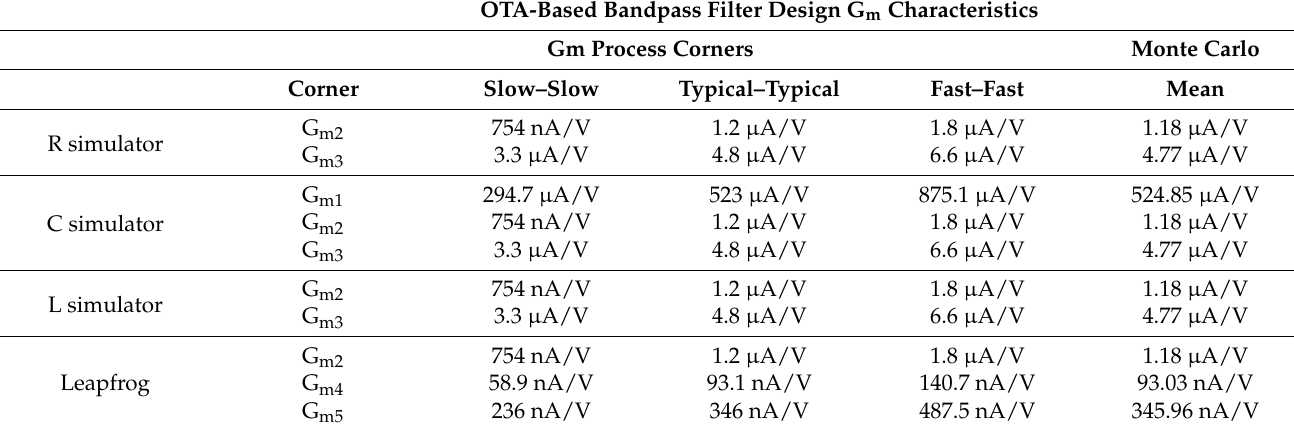
Table 5. Corner analysis of each OTA